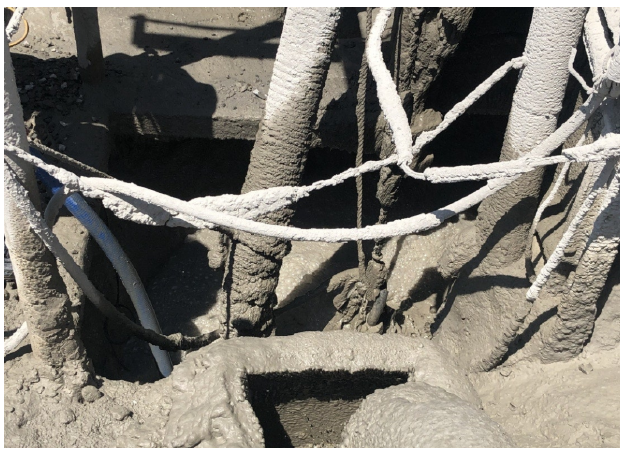
Figure 2. Concrete slurry water extraction. Table 1. Chemical composition of supernatant water (obtained by ICP spectroscopy).